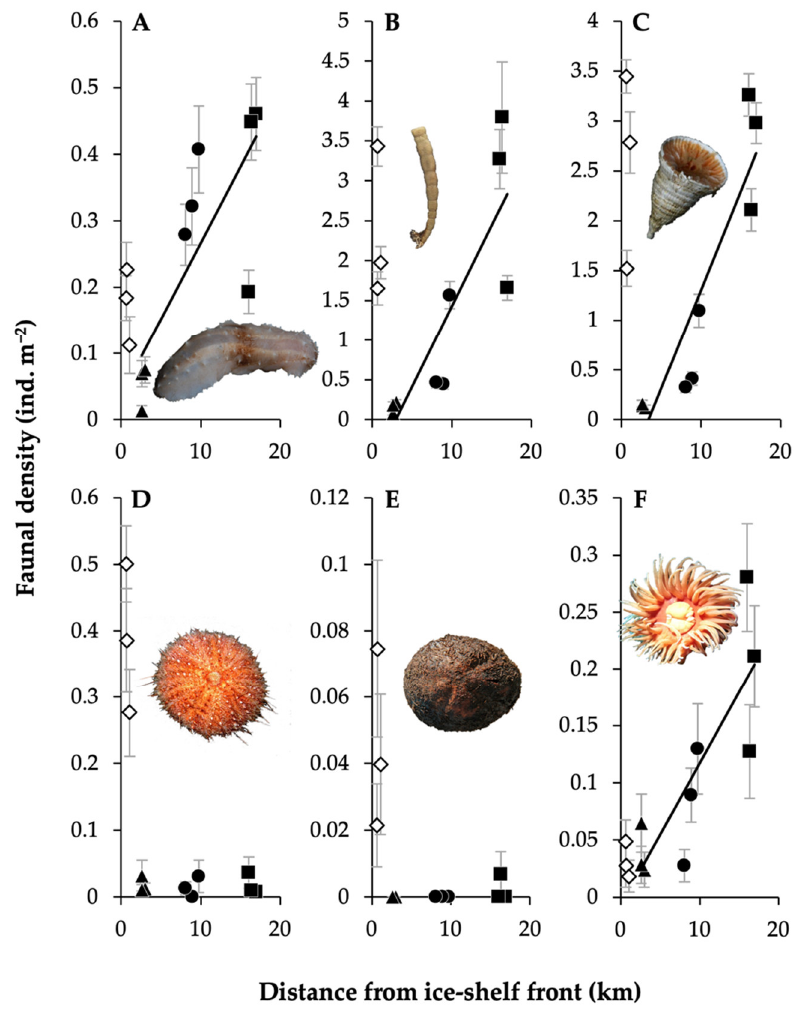
Figure 5. Functional group densities can alter differently relative to ice-shelf proximity. Mean functional group densities (ind. m − 2 ) ( ± SE) of samples with distance from the ice-shelf front (km), with an example taxon for each group (images provided by D.K.A.B.): ( A ) deposit-feeding crawlers; ( B ) pioneer sessile suspension feeders; ( C ) hard sessile predator/scavengers; ( D ) grazers; ( E ) hard deposit-feeders; and ( F ) soft sessile predator/scavengers. Site LCP1 = diamonds, LCP2 = triangles, LCP3 = circles, and LCP4 = squares; white-filled symbols indicate (due to water mass disparities, see [90]) data not included in trend-line generation. R 2 values for ( A – C , F ) = 0.63, 0.85, 0.74 and 0.70, respectively, and regression statistics indicated all associated p -values ≤ 0.01.